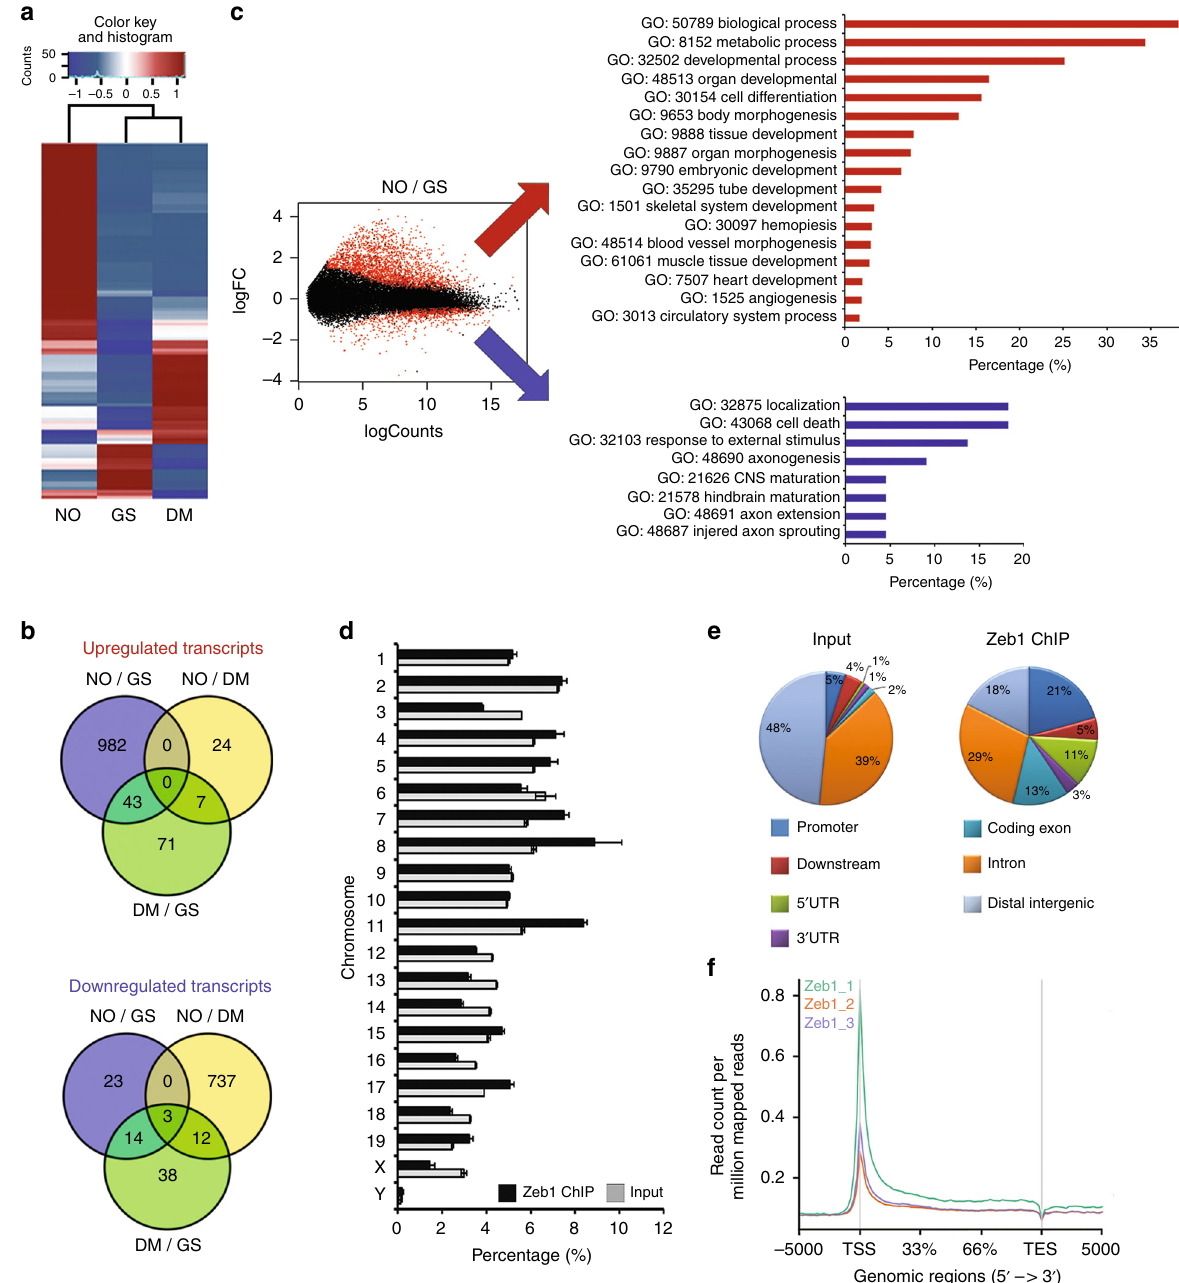
Fig. 1 Identi fi cation of NO-responsive transcripts and Zeb1-associated genomic regions. a Heatmap showing the 50 most differentially regulated genes in mESC cultured for 24 h in GS, DM, or NO identi fi ed by total RNA sequencing analysis ( n = 3 each group). Red and blue represent over- and under- expressed genes, respectively. b Venn diagrams depicting the distribution of upregulated (upper panel) and downregulated (lower panel) unique or common transcripts among GS, DM, or NO conditions. c Left panel: MA plot of differentially regulated genes expressed in mESC cultured for 24 h in NO compared to GS condition. Red dots show genes with a p adjusted value <0.05. Right panels: Gene ontology analysis of NO-differentially regulated transcripts between mESC cultured in GS and NO. Upregulated genes depicted in the upper panel, red bar graph; downregulated genes in the lower panel, blue bar graph. d Distribution of chromatin – associated Zeb1 regions over mouse chromosomes. Black bars: percentage of all chromatin/Zeb1-associated regions; gray bars: background derived from input samples ( n = 3). e The pie chart illustrates the distribution of chromatin-associated Zeb1 regions (Zeb1- ChIP) over speci fi c genomic features depicted as follows: (i) promoters encompassing 3000 bp upstream of the transcription start site (TSS) (blue sector); (ii) downstream regions encompassing 3000 bp from transcription end site (TES) (red sector); 5 ′ UTRs (green sector) and 3 ′ UTRs (purple sector) as well as coding exons (turquoise sector) and introns (orange sectors) relative to the gene bodies; iii) distal intergenic regions (light blue sectors). Input and Zeb1-ChIP represented in the left and right pie chart respectively. f Gene body pro fi le depicting Zeb1-ChIP regions distribution in association with TSS or TES produced by